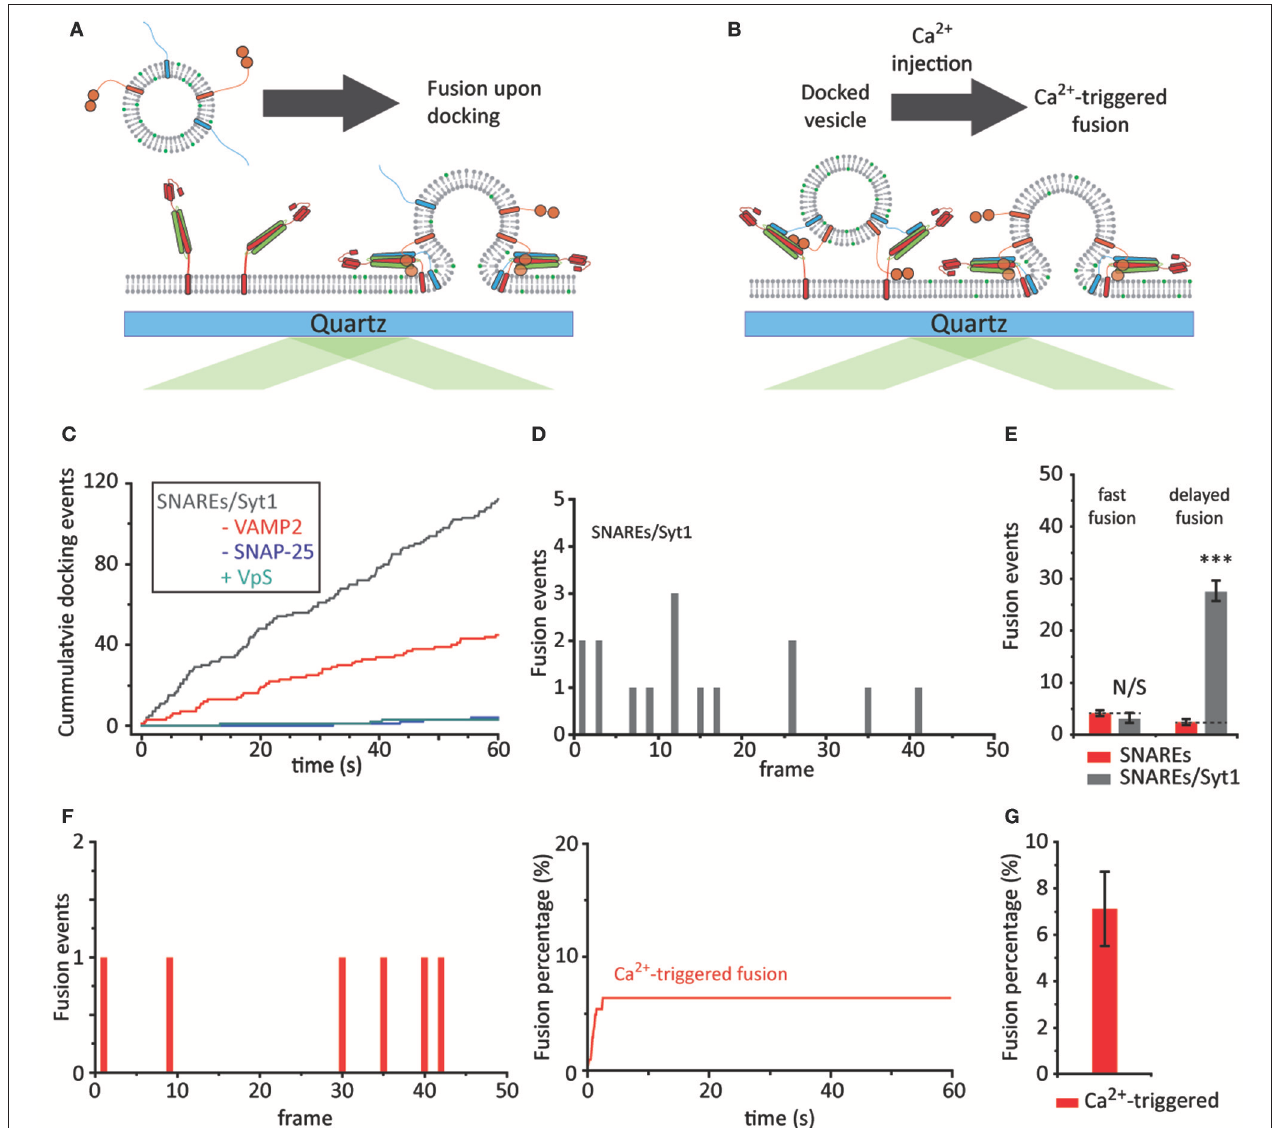
FIGURE 3 | Dissection of membrane fusion steps. (A) Schematics for the single vesicle-to-SBL fusion assay with Syt1 and without Ca 2 + . (B) Schematics for Ca 2 + -triggered single vesicle-to-SBL fusion assay of a priori docked vesicles. (C) Representative cumulative count of docking events against time from one individual recording. The gray trace indicates v-vesicles reconstituted with Syt1 and VAMP2 and the red trace indicates vesicles with just Syt1. Controls without SNAP-25 and with VpS are also shown in blue and green, respectively. (D) A representative histogram of fusion events plotted against docking-to-fusion frame delay (20ms) from one individual recording. (E) The number of fast and delayed fusion events. The red bars indicate v-vesicles reconstituted with just VAMP2 (23 fusion events, also shown in Figure 1G ) and gray bars indicate v-vesicles reconstituted with VAMP2 and Syt1 (90 fusion events). (F) Ca 2 + -triggered fusion events plotted against time. A representative histogram of frame delay (20ms) between Ca 2 + injection and fusion within the first 100s (left) and the cumulative plot during the entire 1min recording is shown (right). (G) The fusion probability of Ca 2 + -triggered events within a 1min recording. A total of 74 fusion events among 1,106 docked vesicles were observed from three independent recordings. For (E,G) the data are shown as means ± SD . Statistical significance was assessed by Student’s t -test (*** p < 0.005; NS, no significant difference; n = 3 independent